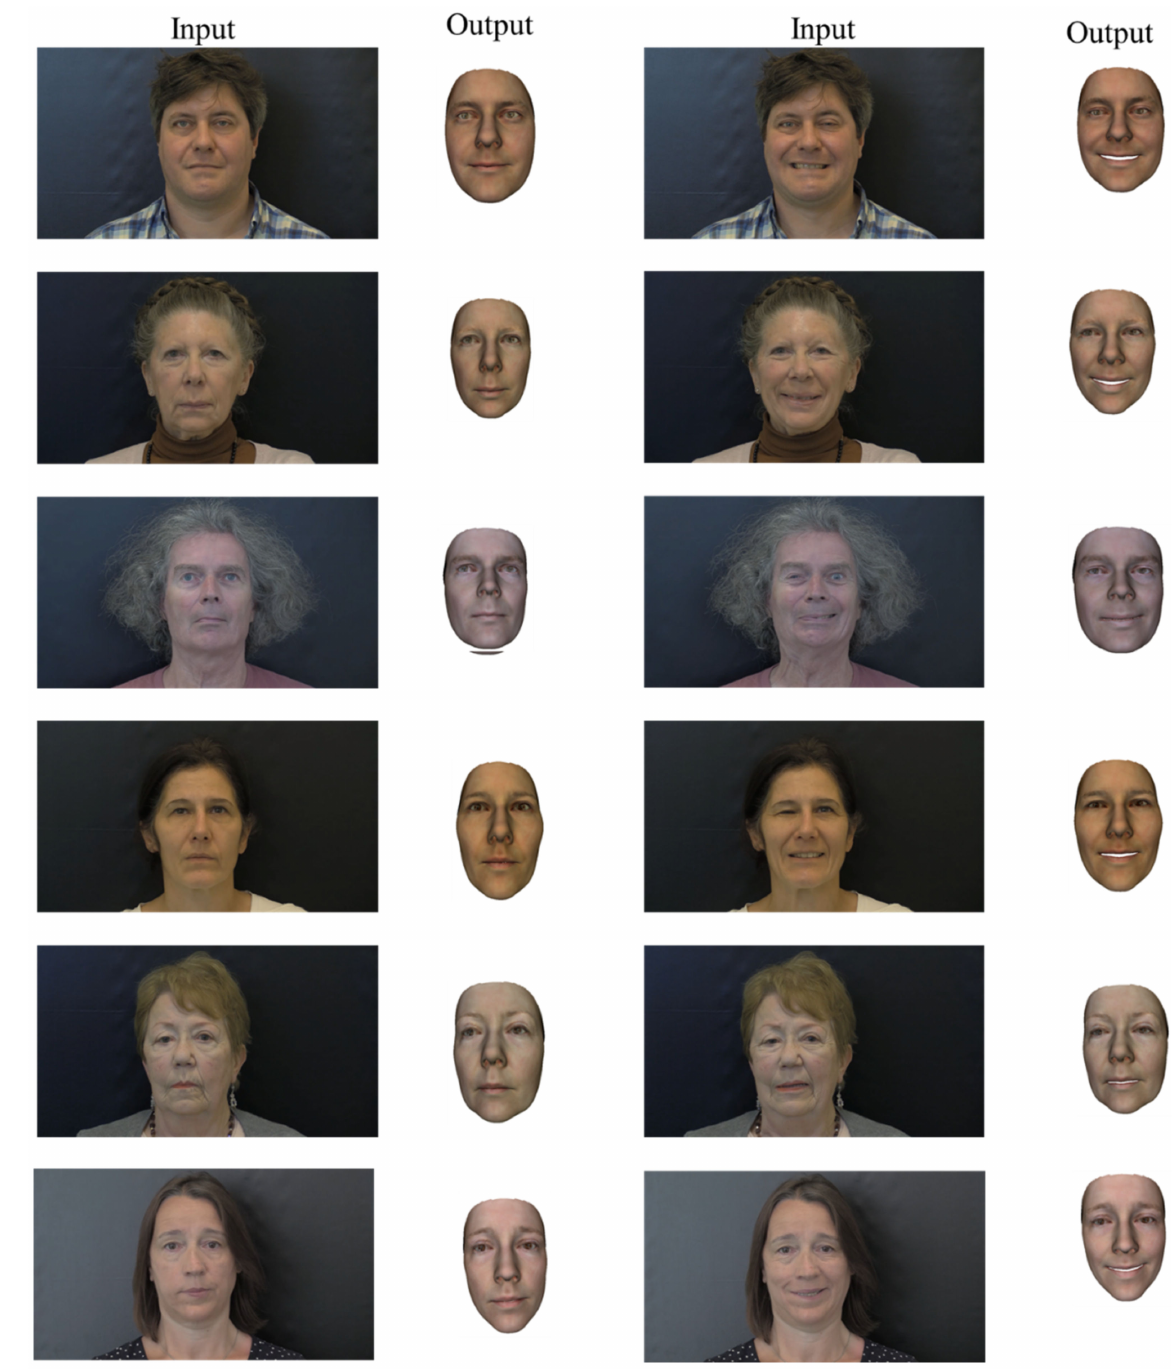
Figure 14. The 3D face reconstruction of the last six facial palsy patients using method 3 (deep 3D face reconstruction) using images from CHU